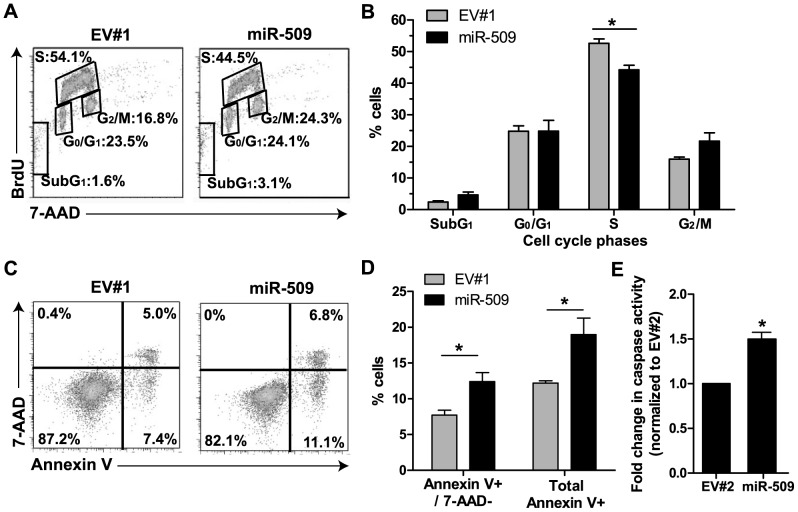
Enforced miR-509 expression in decreased proportion of cells in S-phase, induced apoptosis and activated caspase-3/7.(A) Representative flow cytometric plots showing cell cycle distribution of NALM6 cells transduced with empty vector (EV#1) or miR-509 overexpressing lentivirus. On day 3 after transduction, cells were labeled with BrdU for 1 h. Cells were then fixed overnight and stained on the next day with both BrdU and 7-AAD before analysis by flow cytometry. Percent of cells at each phase of cell cycle are boxed as indicated. (B) Frequencies of cells at the different phases of cell cycle. Means ± SEMs of 3 independent experiments with statistical analysis by Student's t test. *p<0.05. (C) Representative flow cytometric plots of cell death distribution of NALM6 cells transduced with EV#1 or miR-509 overexpressing lentivirus. Cells were stained with both Annexin V and 7-AAD before analysis by flow cytometry on day 4 after transduction. Numbers represent the frequency in each quadrant. (D) Frequencies of apoptotic cells which are Annexin V-positive (Annexin V+) and 7-AAD negative (7-AAD–), as well as total Annexin V+. Means ± SEMs of 3 independent experiments with statistical analysis by Student's t test. *p<0.05. (E) NALM6 cells were transduced with empty vector #2 (EV#2) or miR-509 overexpressing lentivirus, and cells were seeded in 384-well plate on day 3 after transduction. On day 7 after transduction, caspase-3/7 activity was measured and fold-change in caspase activity was normalized to EV#2. Means ± SEMs of 3 independent experiments done in triplicates, with statistical analysis by Student's t test. *p<0.05.